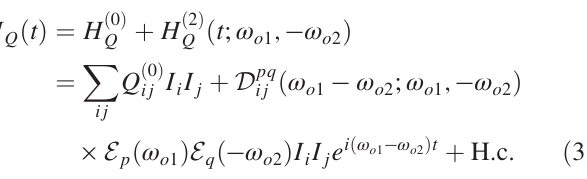
FIG. 1. Illustration of the ONQ effect. (a) A semiclassical illustration of the ONQ effect. Under two photons with frequencies ω ω , respectively, the electron cloud vibrates with frequency j ω o 2 (b) Quantum energy level diagram of the ONQ effect. Electrons do (virtual) transitions between three orbitals and modulate the EFG at the nuclear site. Nuclear spins can transit between two energy levels if the frequency matching condition is